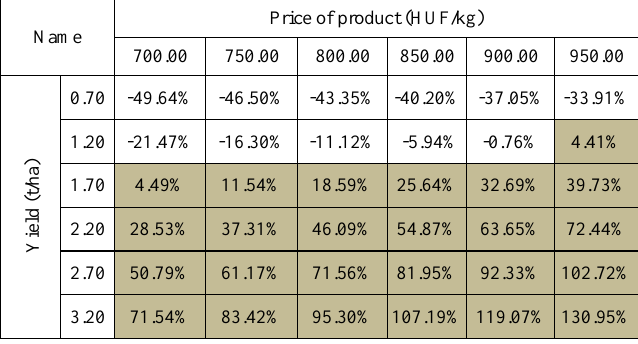
Table 10. Cost related profitability of the production of dried walnut as a function of average price and